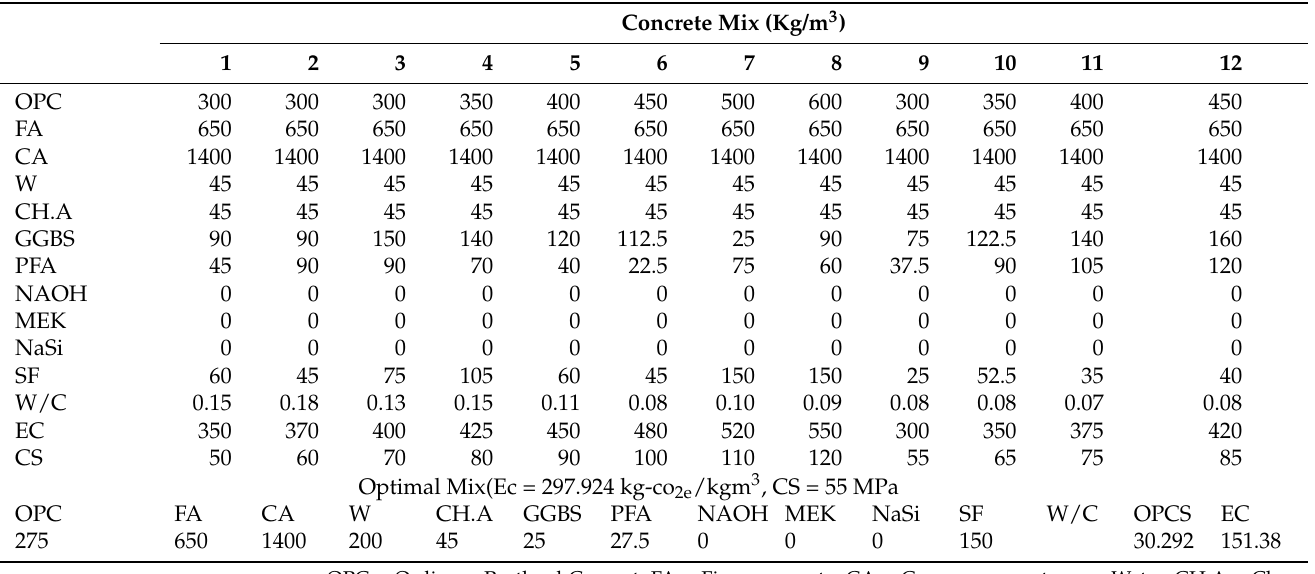
OPC = Ordinary Portland Cement, FA = Fine aggregate, CA = Coarse aggregate, w = Water, CH.A = Chem- ical admixture, GGBS = Ground granular base slag, PFA = Pulverised fly ash, NAOH = Sodium hydroxide